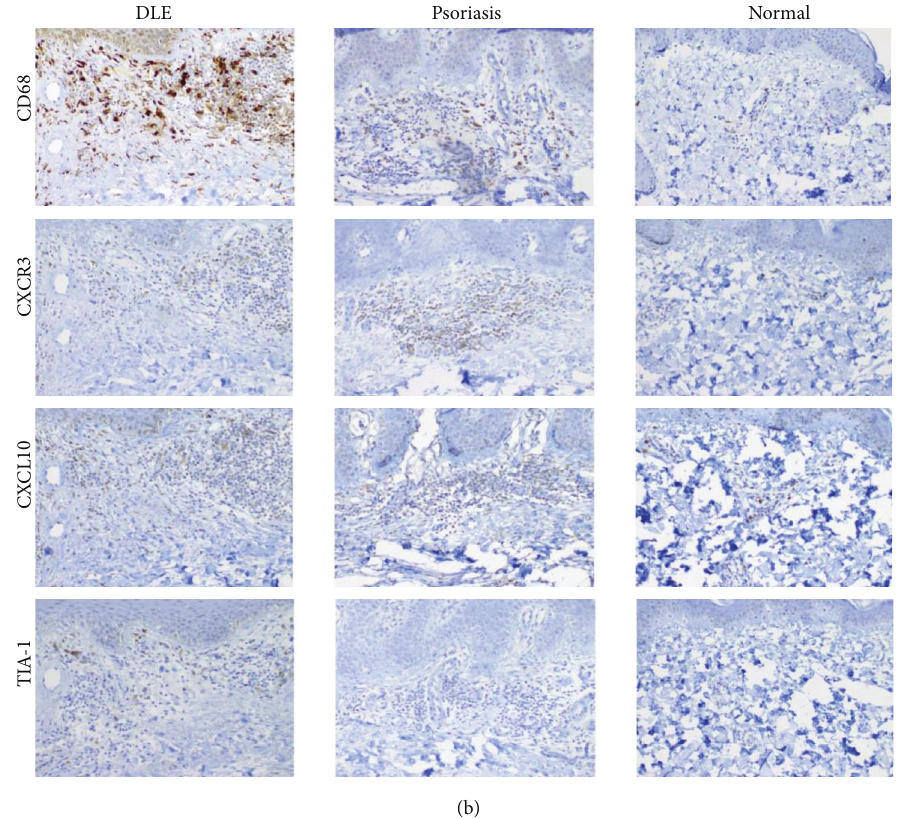
Figure 2: Comparisons of staining of T cell, B cell, and macrophage markers (CD3, CD4, CD8, CD20, CD68, CXCR3, CXCL10, and TIA-1) in the perivascular area of DLE lesional skin ( 𝑁 = 23 ), psoriasis lesional skin ( 𝑁 = 11 ), and normal skin ( 𝑁 = 5 ). (a) The perivascular area of DLE lesional skin contained higher levels of CD3 + T cells, CD20 + B cells, and CD68 + macrophages, CXCR3, and TIA-1 compared with normal skin. ∗ 𝑃 < 0.01 ; ∗∗ 𝑃 < 0.001 ; ∗∗∗ 𝑃 < 0.0001 . (b) H&E and various immunostainings showed that the perivascular area of DLE lesional skin contained higher levels of CD3 + T cells, CD20 + B cells, and CD68 + macrophages, CXCR3, and TIA-1 compared with normal skin. No significant differences were discovered between DLE and psoriasis lesional skin. Magnification: